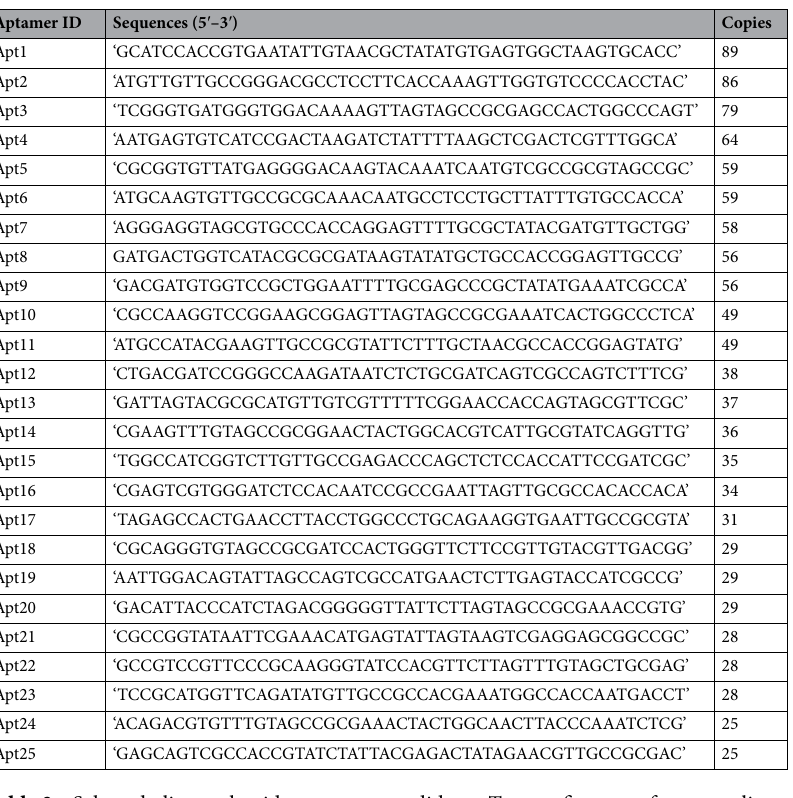
Table 2. Selected oligonucleotide sequence candidates. Twenty-five most frequent oligonucleotide sequences obtained after next-generation sequencing (NGS) of the 8th Cell-Selex cycle. Only the sequence corresponding to the random region is shown. Primer binding sites were neglected in this